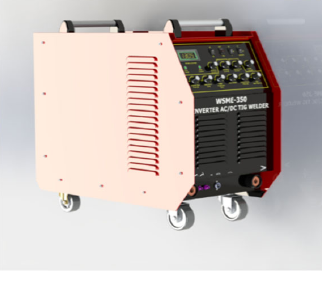
Fig. 2. Rendering in